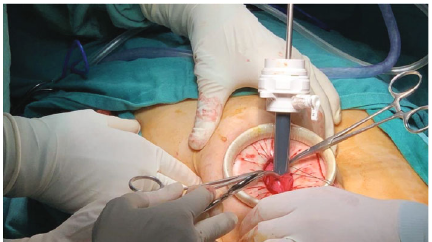
Figure 3: The fi gure demonstrates the 11mm trocar introduced into the cyst cavity to facilitate drainage. A purse-string suture placed around the trocar is also demonstrated. A 5 mm suction tube was used to drain the cystic fl uid contents through the trocar.